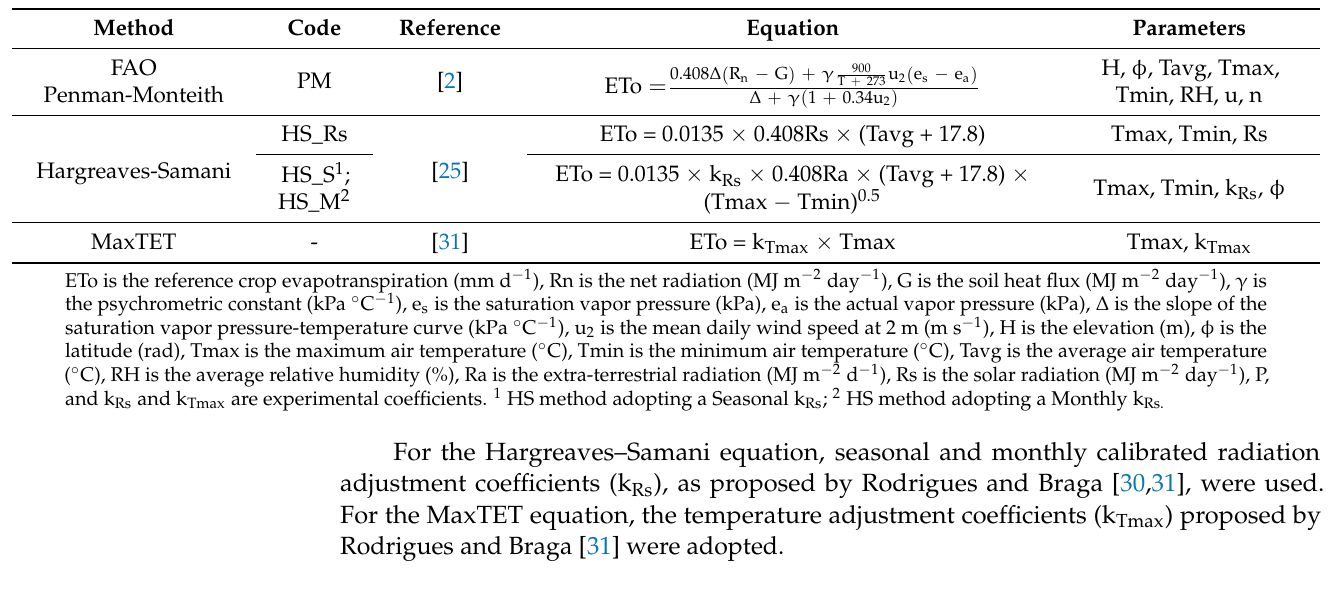
Table 2. Method used to estimate ETo and the parameters applied in each